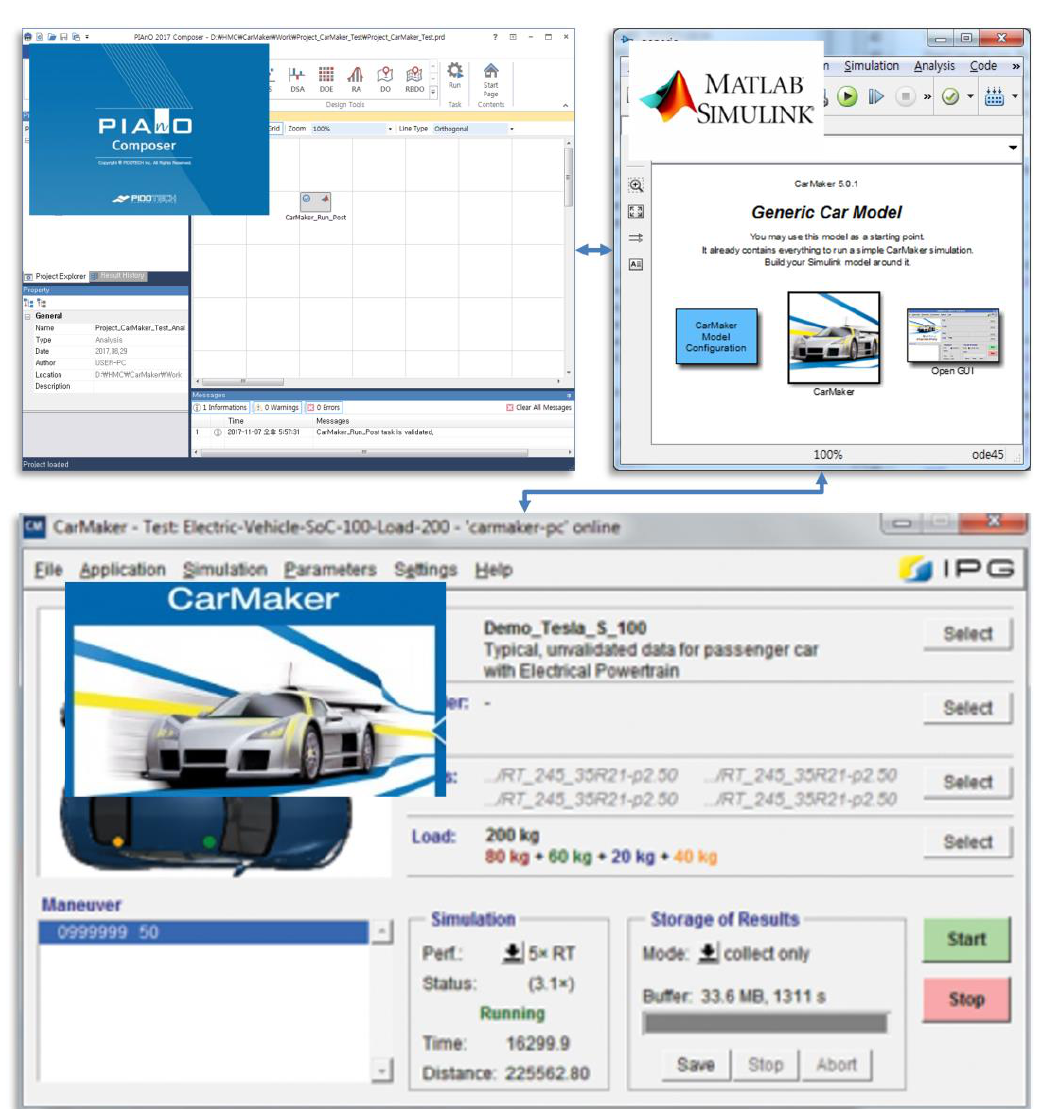
Figure 4. Adjustment of model parameters using optimization tools.